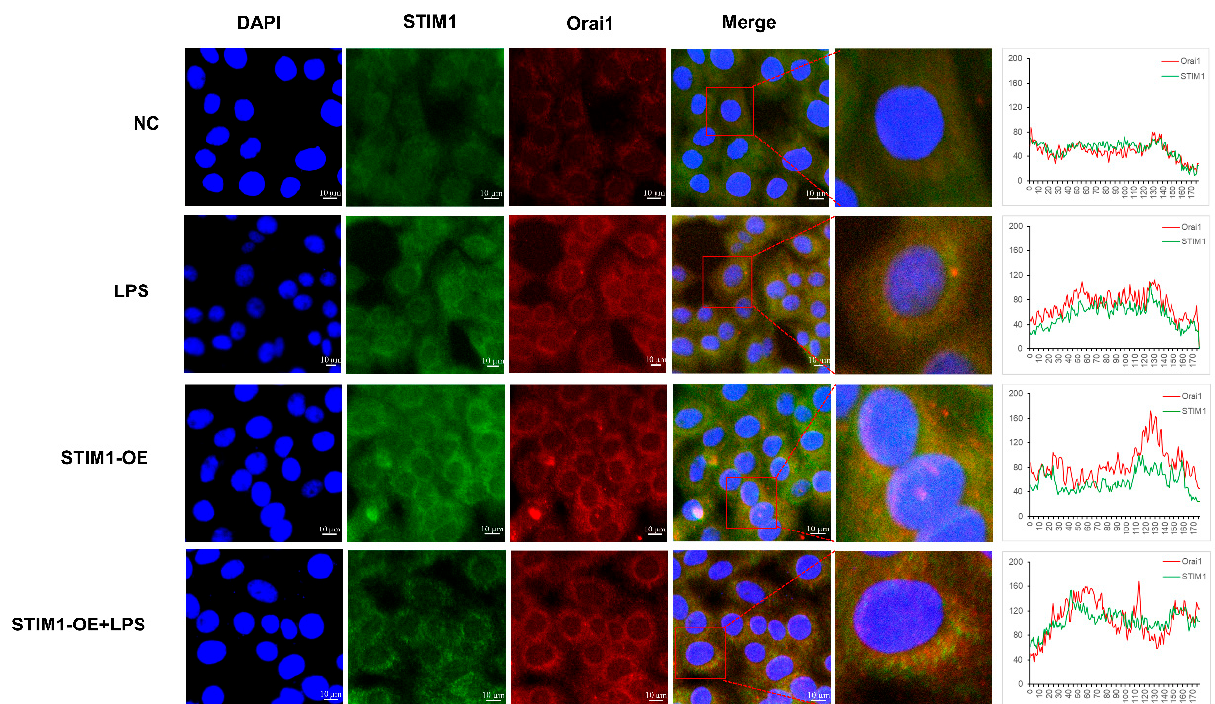
Figure 5. Protein expression and location of STIM1/Orai1 in BMEC. DAPI blue fluorescence was used to label the nuclear locations, FITC green fluorescence was used to label STIM1 protein, and Cy3 red fluorescence was used to label Orai1 protein. ImageJ was used to draw the line graph to show the fluorescence co-location trends.